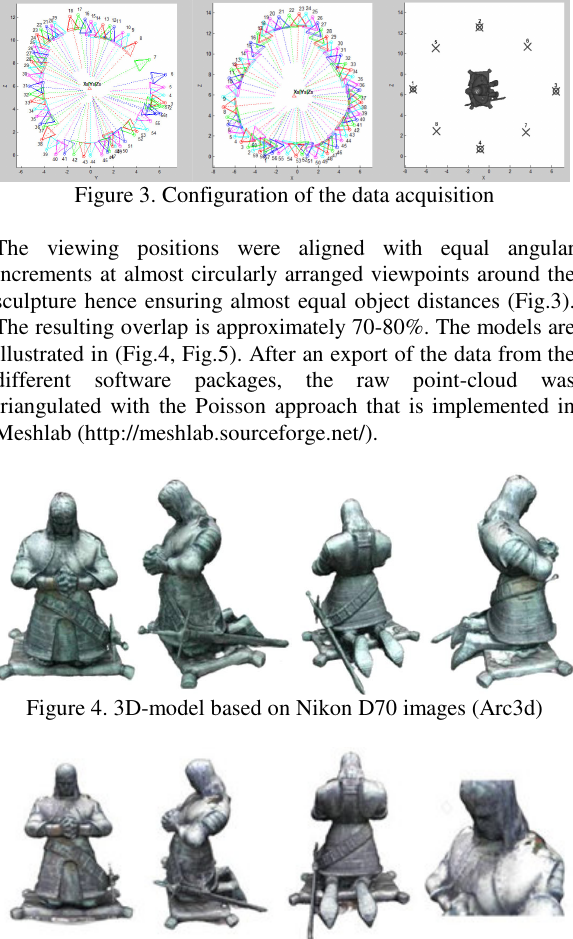
Figure 5. 3D-model based on Casio Exilim images